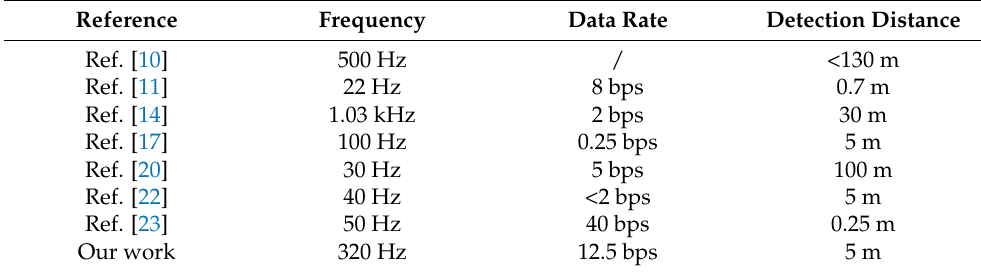
Table 3. Performance comparison of rotating permanent magnet